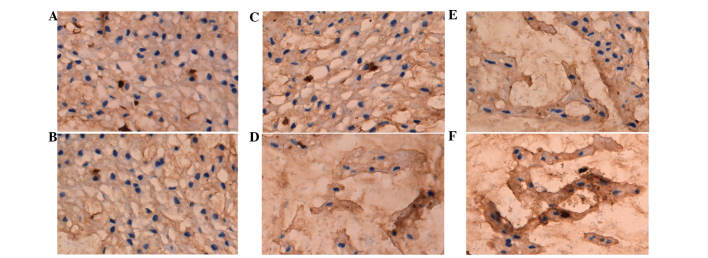
Photomicrographs showing the expression of collagen I in the disc samples. Immunohistochemical staining was used to show collagen I in the disc: (A), (C) and (E) show that the expression of collagen I was not significantly changed. (B), (D) and (F) show that the expression of collagen I significantly increased over time. Original magnification, ×400.